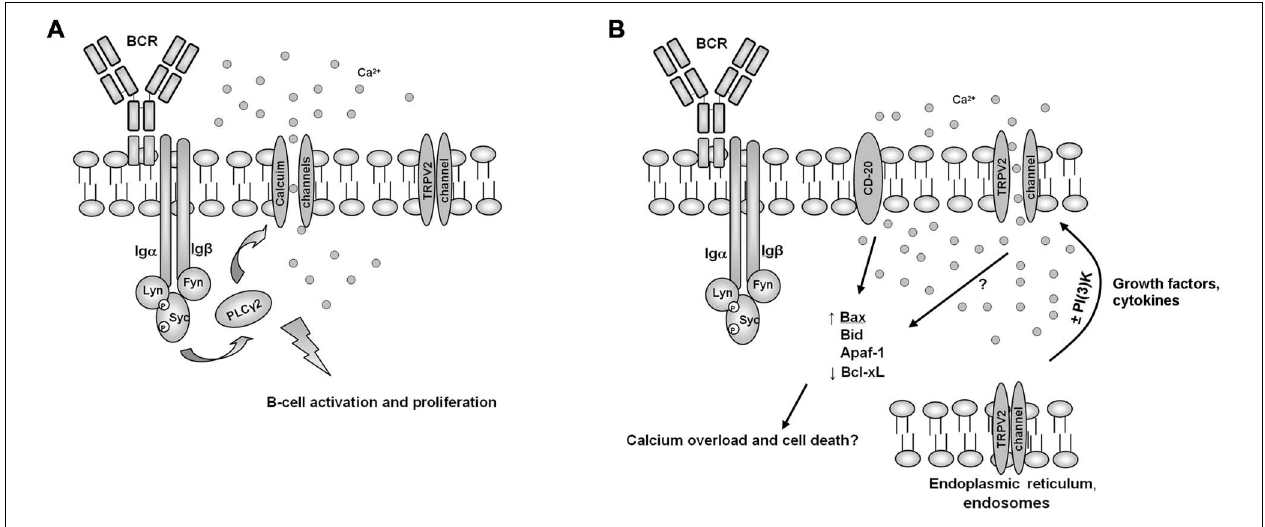
FIGURE 4 |A model for the involvement ofTRPV2 B cell activity regulation. (A) In normal conditions, B cell receptor (BCR) activation induces calcium channels translocation and activation, resulting result in B cell activation and proliferation. (B) Growth factors or cytokines, by